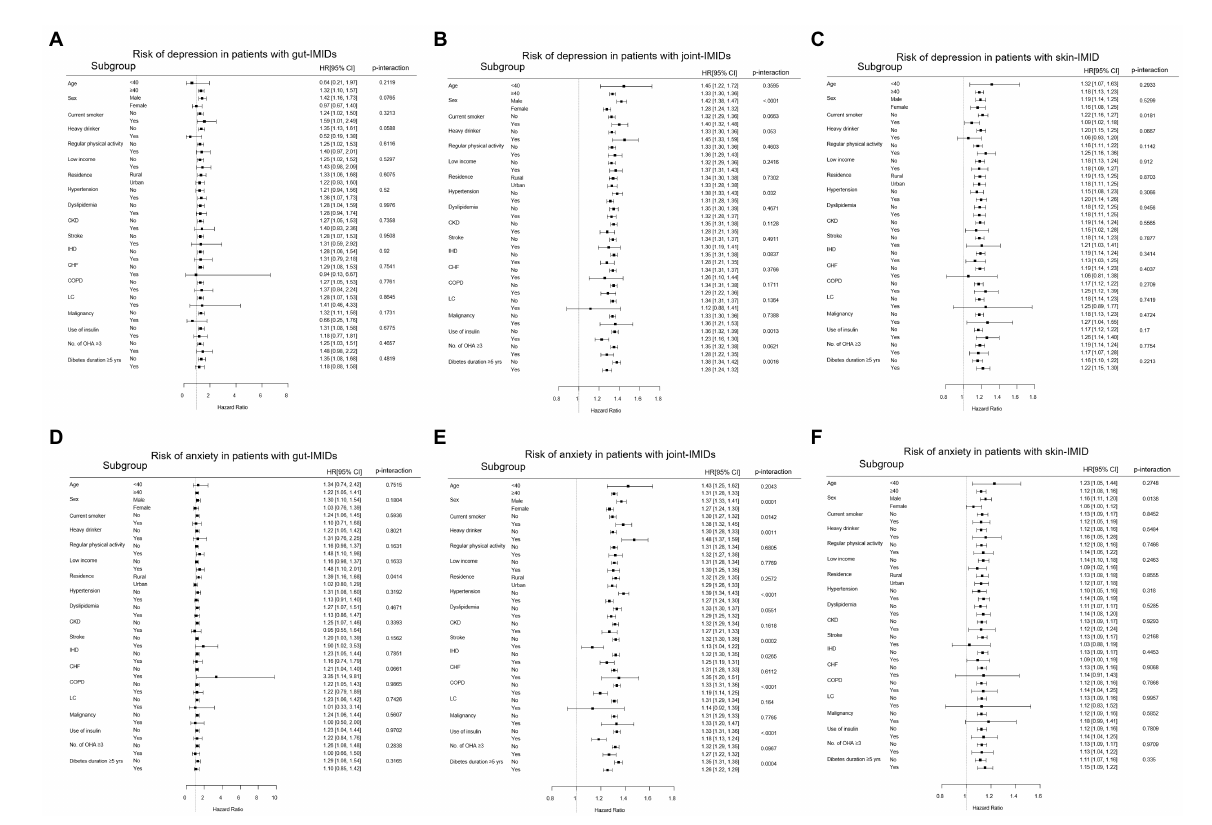
FIGURE 4 Subgroup analyses for the risk of depression in patients with (A) gut IMIDs, (B) joint IMIDs, and (C) skin IMID; and the risk of anxiety in patients with (D) gut IMIDs, (E) joint IMIDs, and (F) skin IMID. IMIDs, immune-mediated inflammatory disease; CKD, chronic kidney disease; IHD, ischemic heart disease; CHF, congestive heart failure; COPD, chronic obstructive pulmonary disease; LC, liver cirrhosis; OHA, oral hypoglycemic agents.